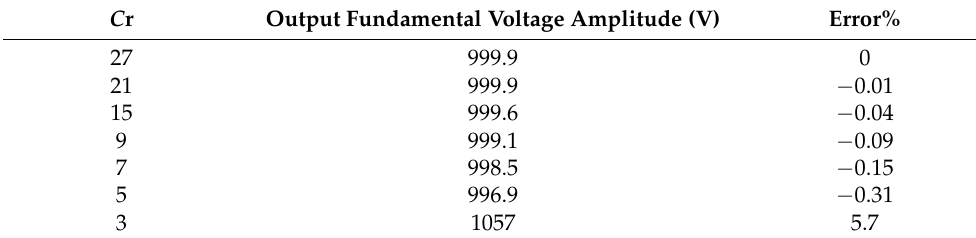
Table 2. Output voltage in 2 L inverter when carrier ratio decreases (1000 V is the referenced output). C